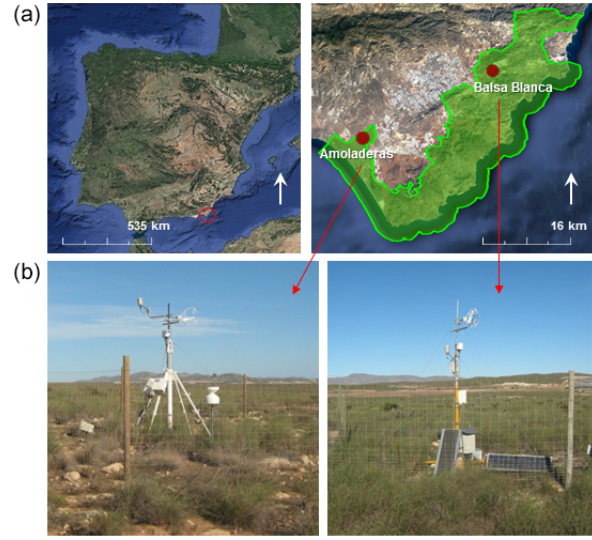
Figure 1. Location (a) and photographs (b) of the experimental sites. Green area represents the Cabo de Gata-Níjar Natural Park (Almería,